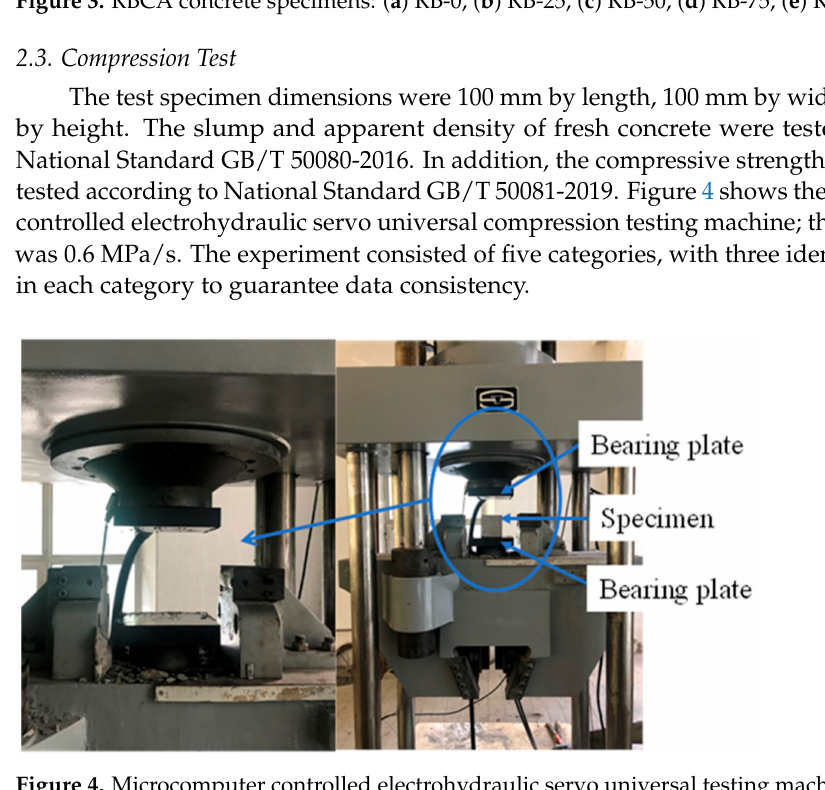
Figure 3. RBCA concrete specimens: ( a ) RB-0, ( b ) RB-25, ( c ) RB-50, ( d ) RB-75, ( e ) RB-100.